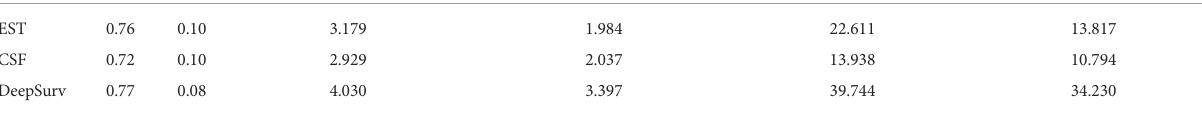
TABLE 3 Comparison of each machine learning model ’ s